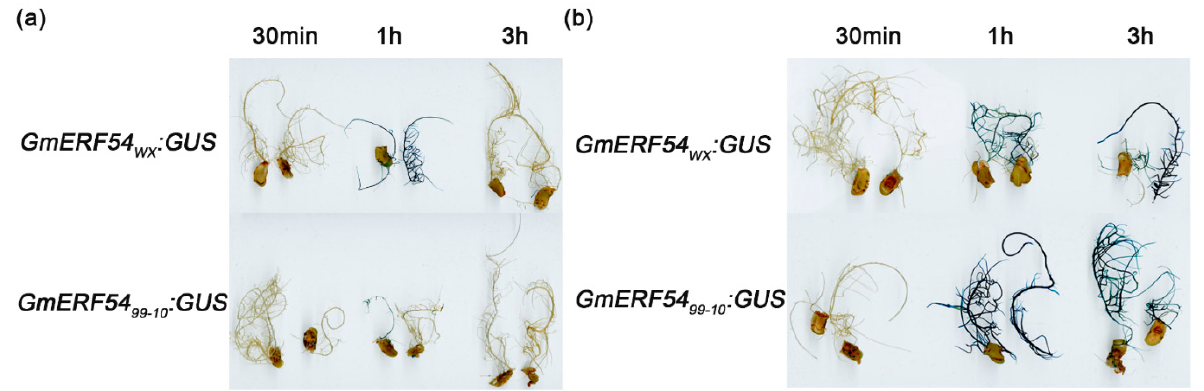
Figure 7. The expression of GmERF54 is regulated by MeJA and IAA. ( a ) GmERF54 WX :GUS and GmERF54 99-10 :GUS transgenic hairy roots were treated with MeJA (100 µ M) for 30 min, 1 h and 3 h. ( b ) GmERF54 WX :GUS and GmERF54 99-10 :GUS transgenic hairy roots were treated with IAA (20 µ M) for 30 min, 1 h and 3 h. The GmERF54 WX :GUS and GmERF54 99-10 :GUS recombinant vectors represent the promoter fragments from WX (insect-resistant cultivar) and 99-10 (insect-susceptible cultivar), respectively.